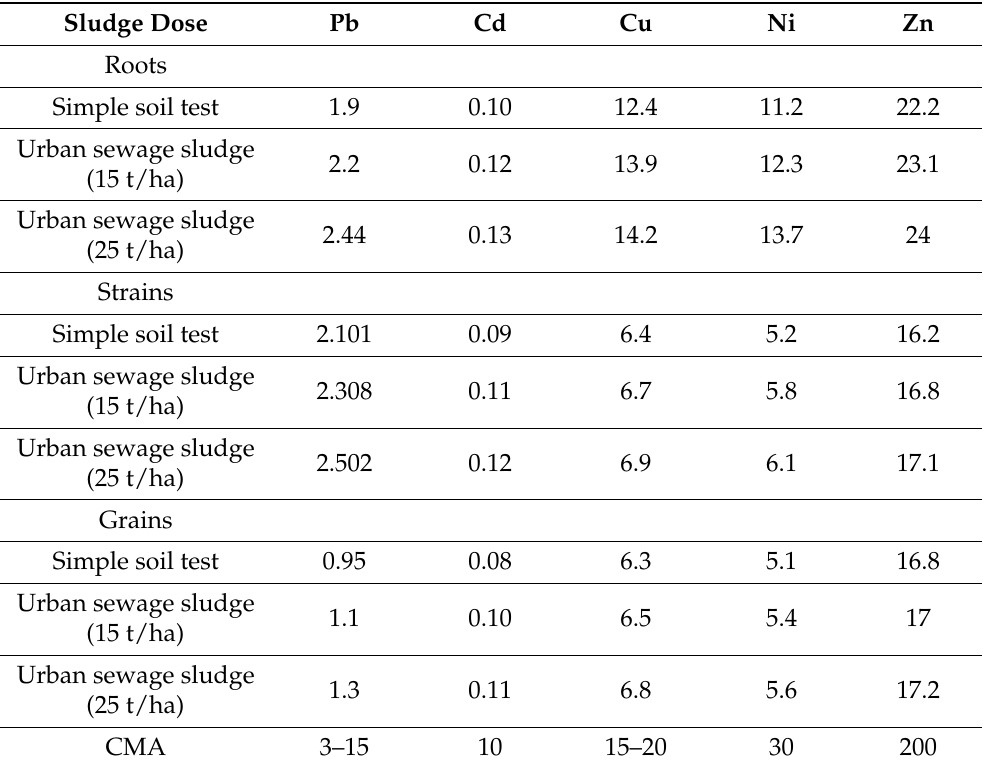
Table 2. The influence of different doses of sludge on the content of heavy metals in the stems, roots and grains of soybean